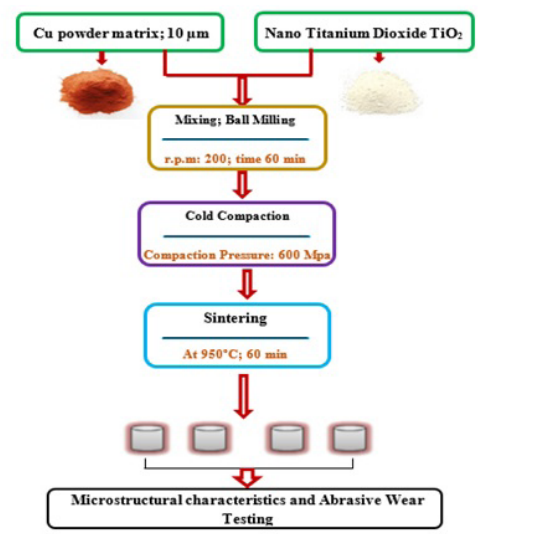
Figure 1. Flow chart and Schematic presentation showing the fabrication path of the present